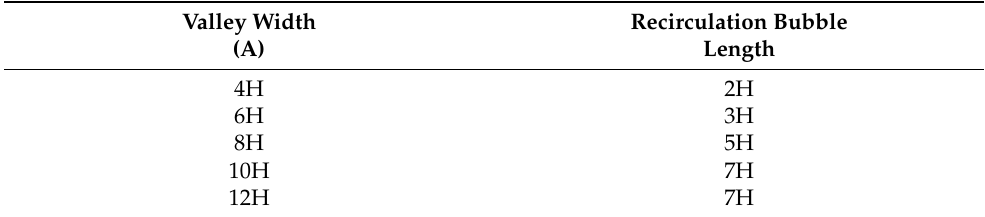
Table 2. Approximate lengths of the inner valley vertical-plane recirculation bubbles based on near-surface longitudinal flow reversal observed at z/H ≤